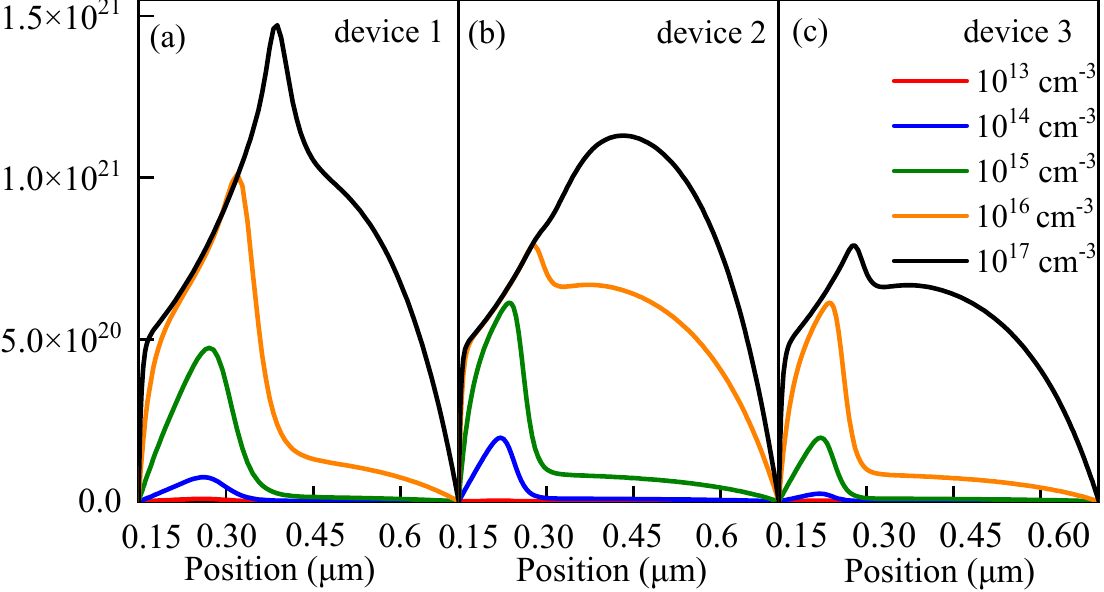
Figure 12. Relationship between N t and R SRH : ( a ) relationship between N t and R SRH in device 1, ( b ) relationship between N t and R SRH in device 2, and ( c ) relationship between N t and R SRH in device 3.